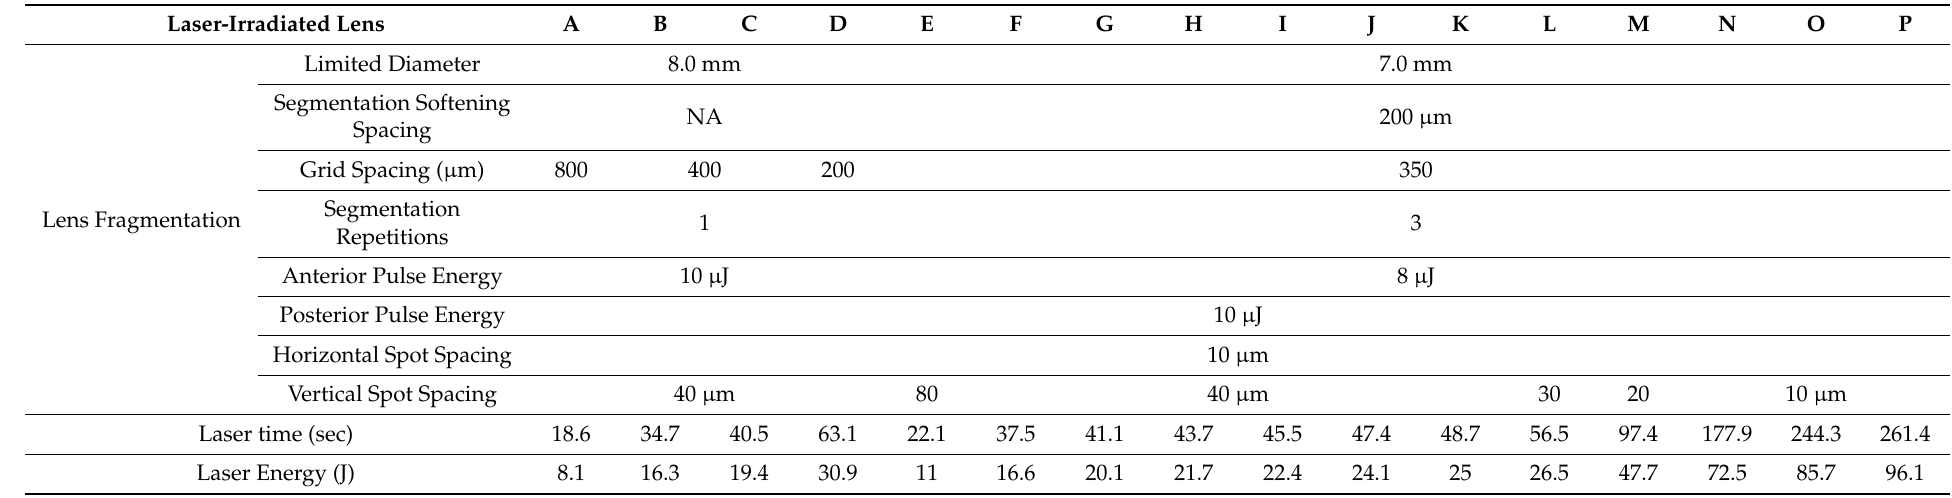
Table 1. Lens fragmentation setting using femtosecond laser surgical system